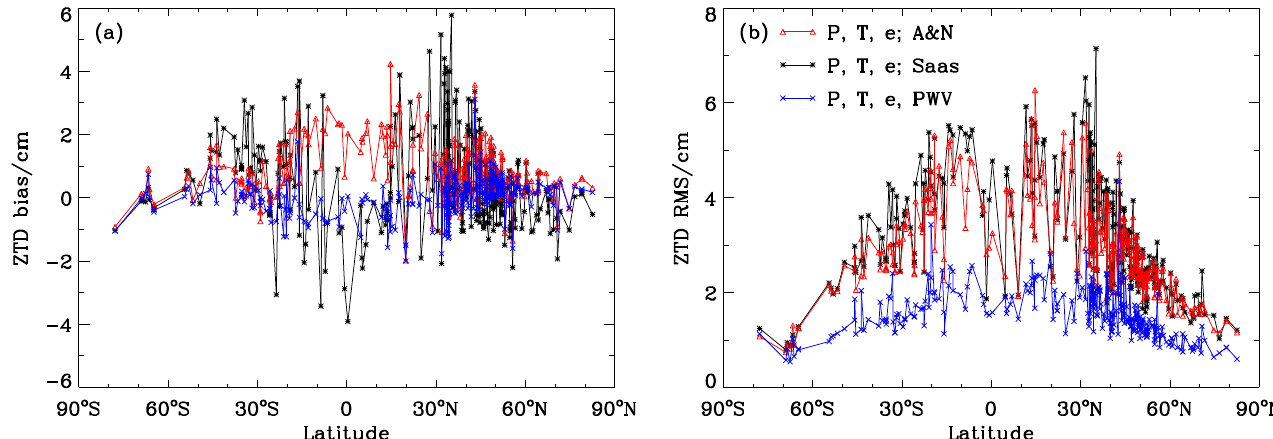
Figure 8. Bias ( a ) and RMS ( b ) values of the differences between GNSS-ZTDs and ZTDs derived from ERA surface analysis data (2.5° × 2.5°) over 302 IGS stations in 2015. The red line and black line indicate results of ZTDs obtained from derived P , T , and e with the A&N model and the Saas model respectively, while the blue line indicates results of ZTDs obtained from derived P , T , e , and PWV.